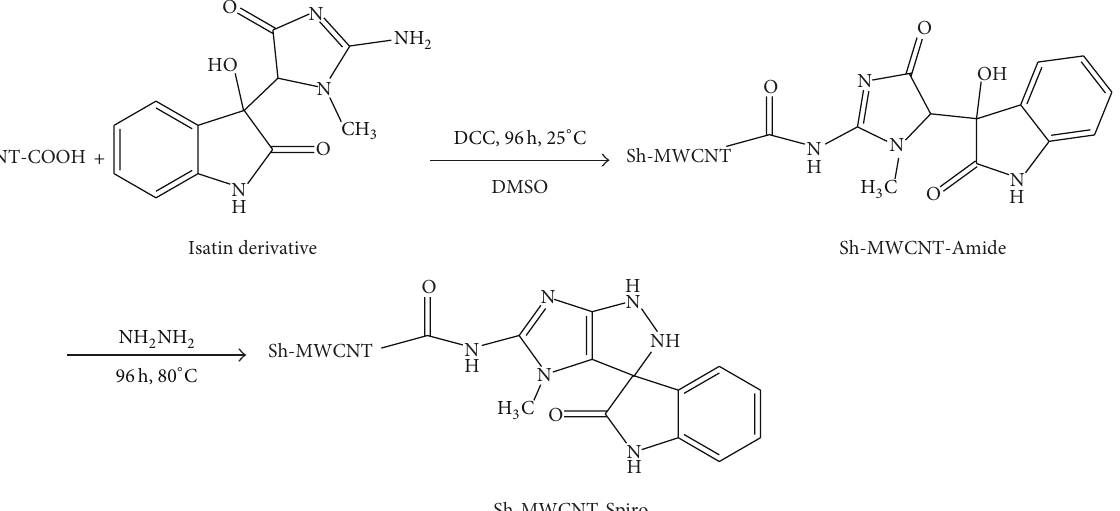
Figure 1: Synthesis route of modified Sh-MWCNT-COOH.